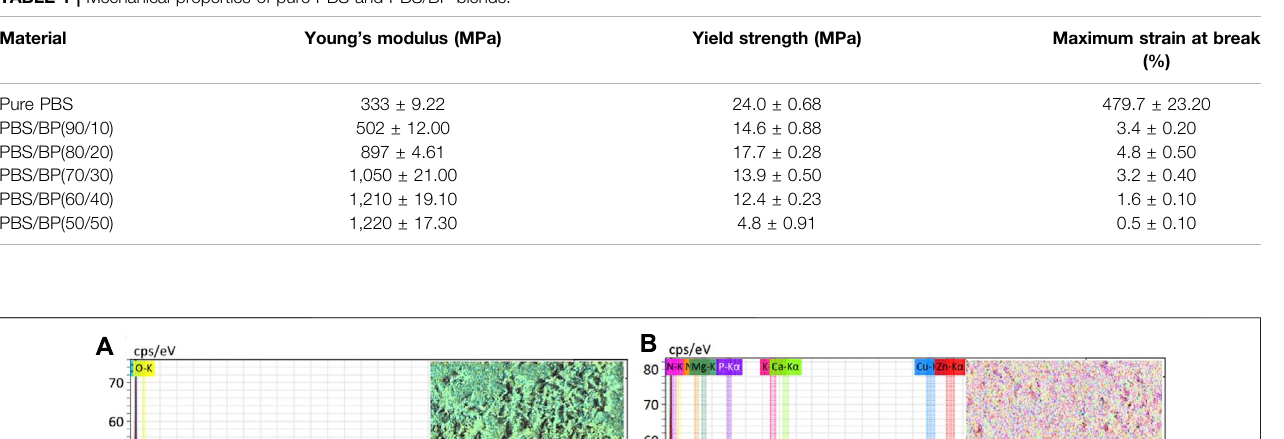
TABLE 1 | Mechanical properties of pure PBS and PBS/BP blends.